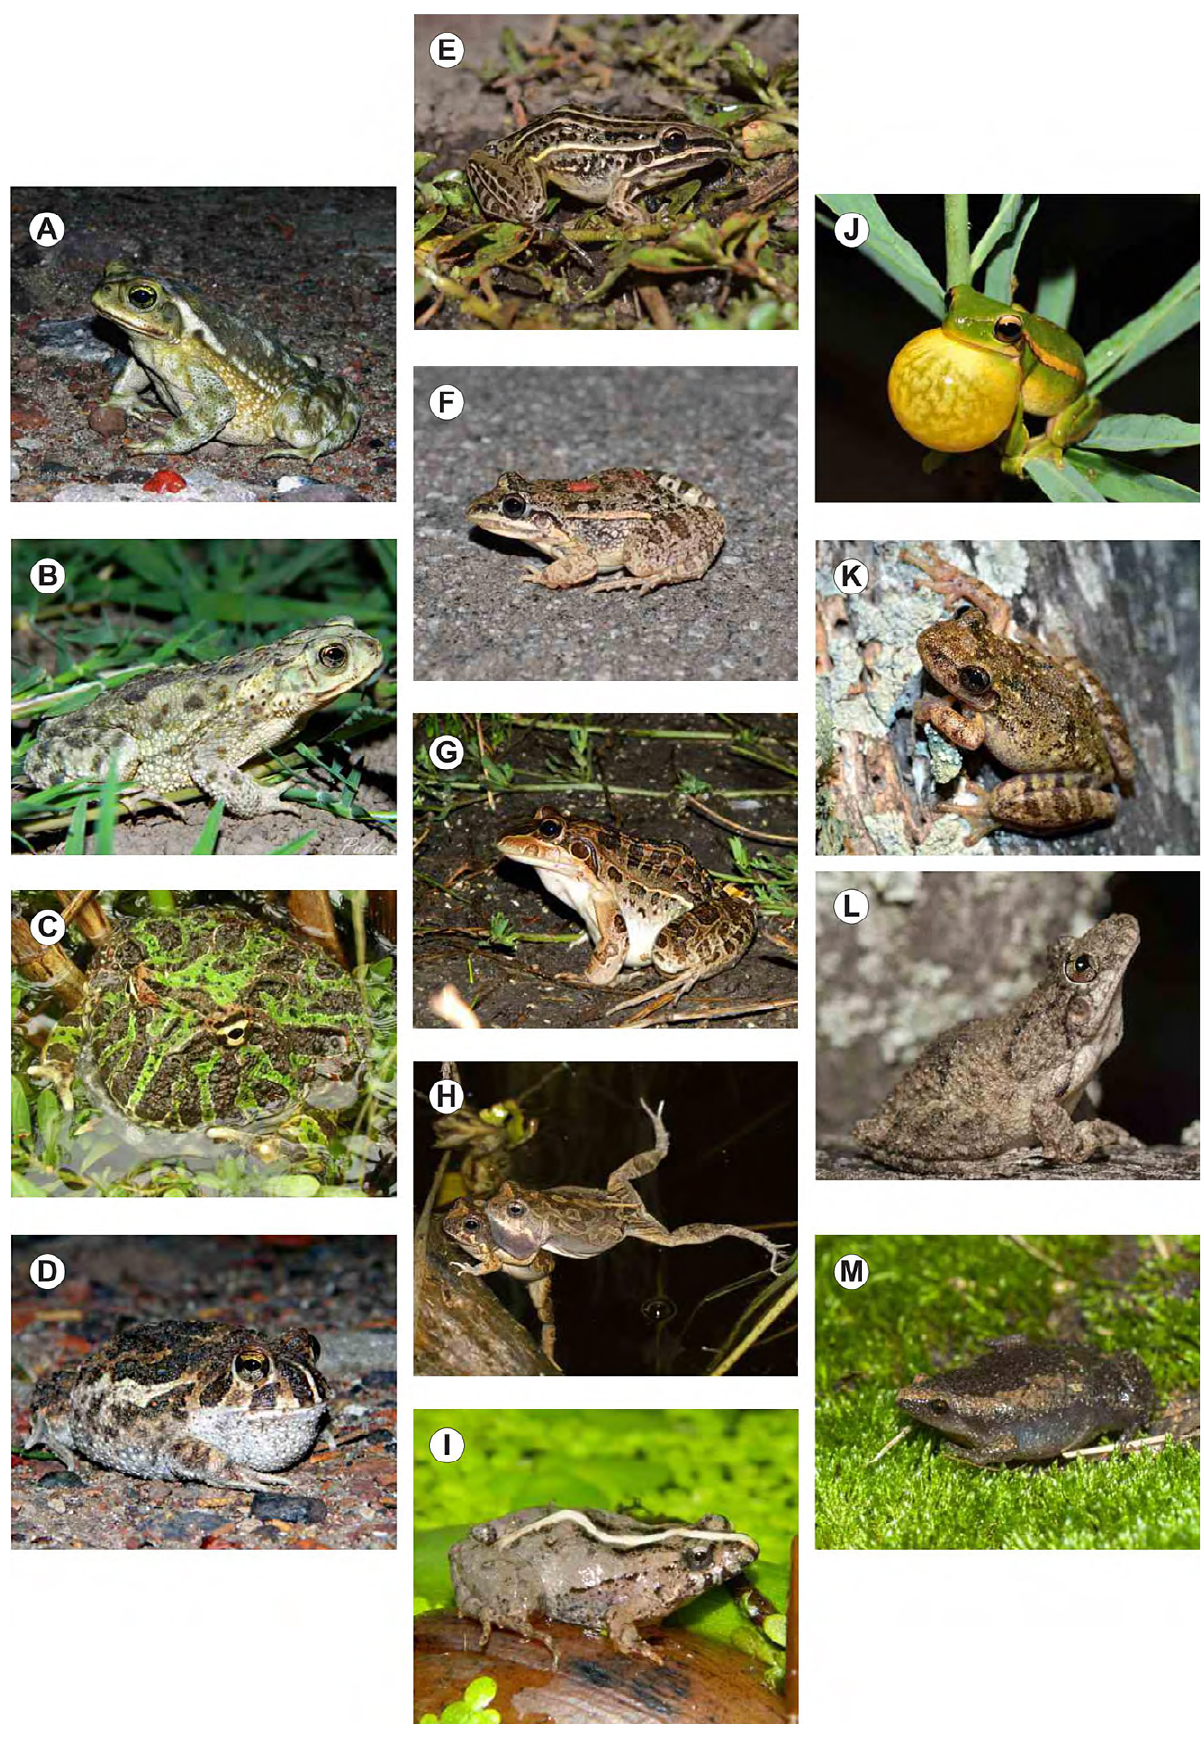
Figure 2. Species of amphibians recorded in field surveys. A ) Rhinella arenarum ; B ) Rhinella fernandezae ; C ) Ceratophrys ornata ; D ) Odontophrynus ameri- canus ; E ) Leptodactylus gracilis ; F ) Leptodactylus latinasus ; G ) Leptodactylus latrans ; H ) Physalaemus biligonigerus ; I ) Pseudopaludicola falcipes ; J ) Hypsiboas pulchellus ; K ) Scinax granulatus ; L ) Scinax nasicus ; M ) Elachistocleis bicolor